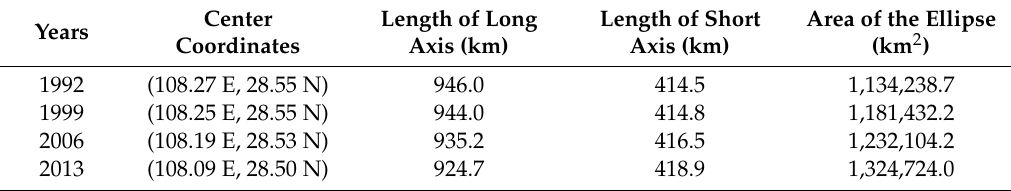
Table 5. Standard deviation elliptical data from night light data on the